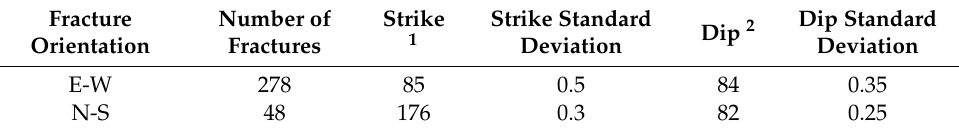
Table 3. Mean pole of the fracture family as a function of orientation.